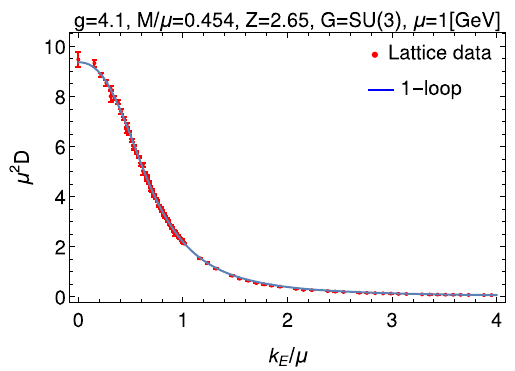
Fig. 5 The gluon propagator D as a function of the Euclidean momen- tum k E in unit of μ . The numerical data (red points) for the gluon prop- agator of the SU(3) Yang–Mills theory on the lattice and the fitted result (blue solid line) to the scaled analytical expression of the gluon prop- agator D in the one-loop level of the massive Yang–Mills model with fitting parameters g , M and Z